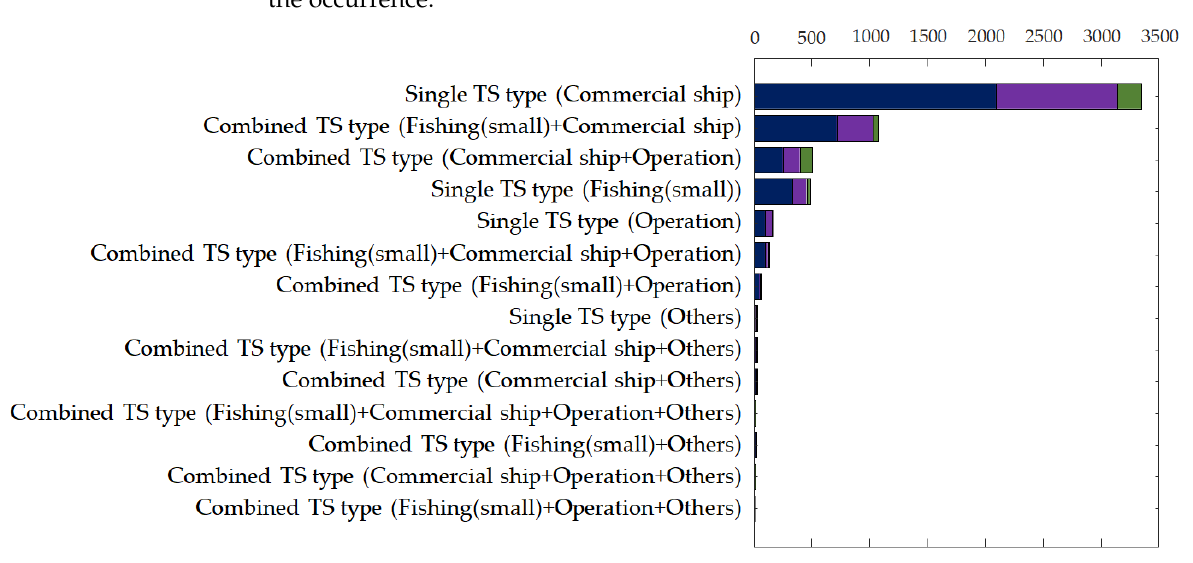
Figure 13. Frequency of each type of ship combination.